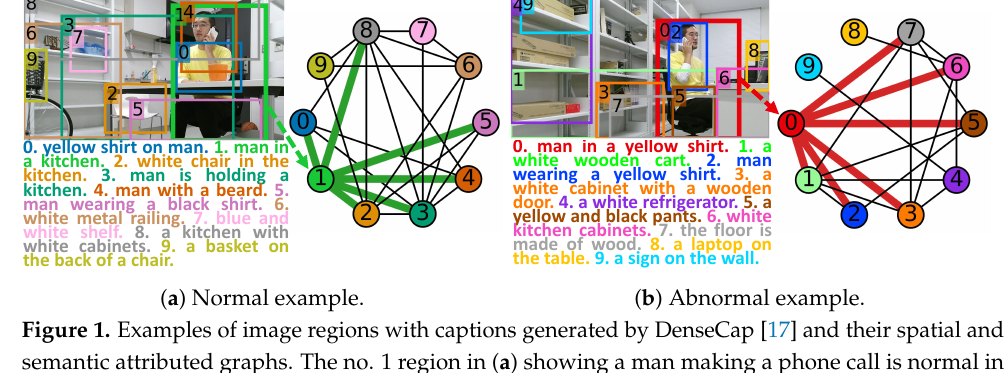
Figure 1. Examples of image regions with captions generated by DenseCap [17] and their spatial and semantic attributed graphs. The no. 1 region in ( a ) showing a man making a phone call is normal in the resting area, while the no. 0 region in ( b ) with the same behavior is abnormal in the working area. By considering the spatial and semantic relations among regions, the no. 1 region in ( a ) and the no. 0 region in ( b ) with their contexts are represented as nodes 0 and 1 with their neighbors connected by green and red edges in ( a ) and ( b ),